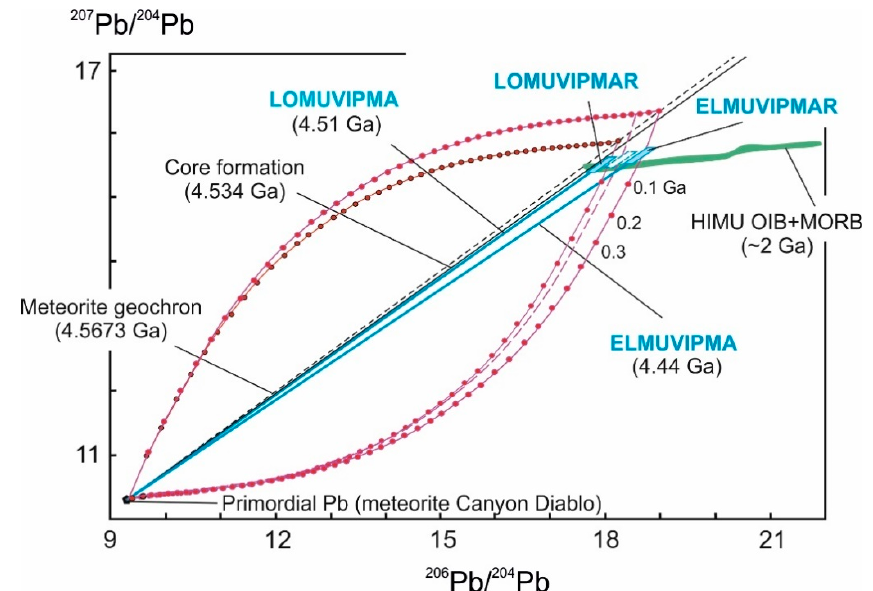
Figure 2. Schematic diagram of uranogenic Pb evolution. Shown are the meteorite geochron [83], the core formation line, the HIMU OIB + MORB trend [18], and the LOMUVIPMA and ELMUVIPMA lines (this work). The LOMUVIPMA and ELMUVIPMA lines yield limited compositions LOMUVIPMAR and ELMUVIPMAR that originated from stepwise solidification of the planetary magma ocean. All geochrons are focused on the primordial lead isotope ratios determined in a troilite from the Canyon Diablo meteorite (Nanton): 207 Pb/ 204 Pb = 10.307094, 206 Pb/ 204 Pb = 9.305875 [84].